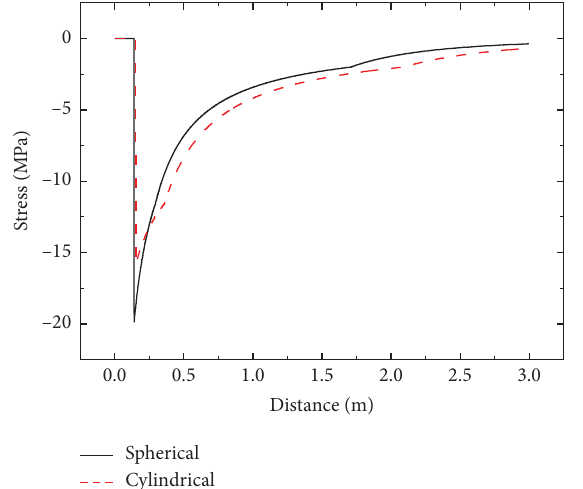
Figure 4: Stress distribution of different charge structures in the Table 4: Characteristic parameters of different explosives.